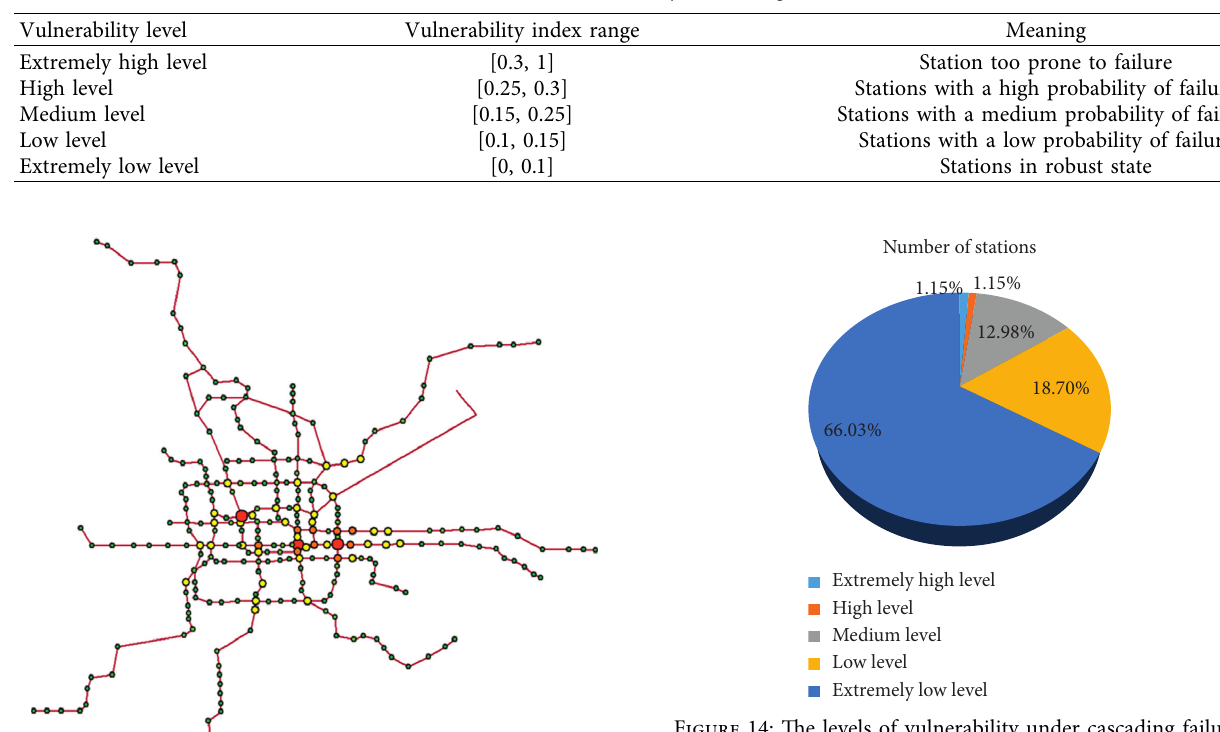
Figure 12: The vulnerability under the station with the largest intensity interruption. (a) Ratio of node failure. (b) Loss flow ratio. Table 2: Vulnerability index range.